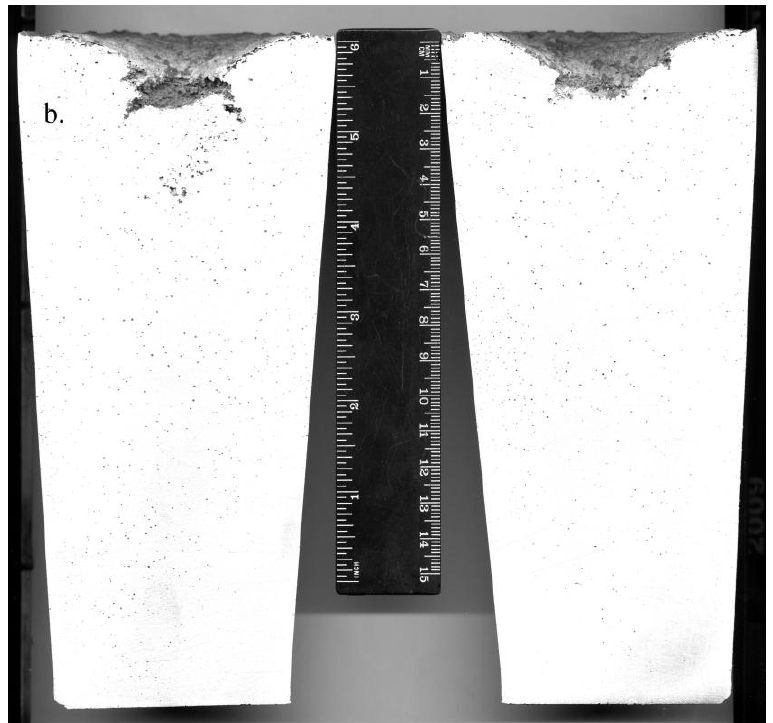
Figure 4. Cylindrical casts produced using the conventional technology ( a ) and the combined effect by GDT and modification by TiCN ( b ). The shrinkage defect in the untreated alloy is much greater than in the treated alloy.